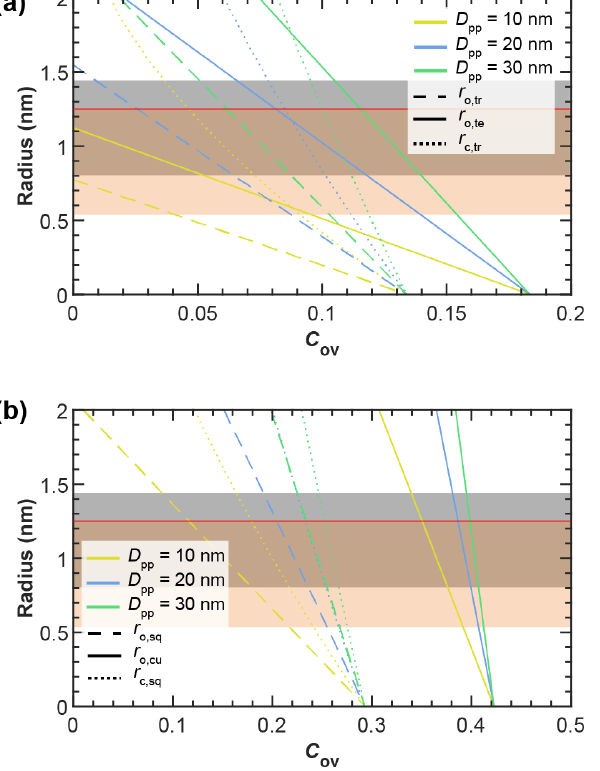
Figure 3. Overview of the radii of key pore dimensions (see Figs. 2, A1, and A2) formed in pores of (a) tetrahedral and (b) cubic pack- ing arrangements between equally sized spherical primary particles of indicated diameter and as a function of primary particle over- lap, with C ov as defined in Eq. (1). A derivation of the indicated pore dimensions can be found in Appendix A. For comparison, the grey- and orange-shaded regions mark the variation in the critical ice embryo radius, r crit , for 200K ≤ T ≤ 235K, as calculated based on Eq. (3) using the parameterizations of Murray et al. (2010) and Ickes et al. (2015), respectively. The horizontal red line denotes a pore radius of r = 1 . 25nm, corresponding to the smallest investi- gated pore size, for which ice formation was experimentally ob- served by David et al.